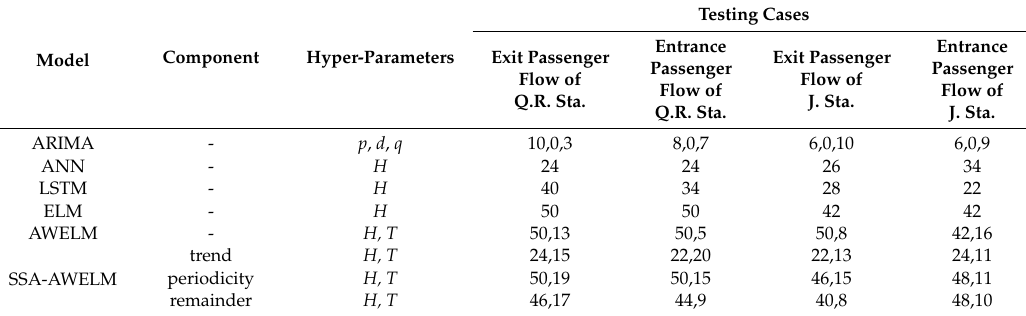
Table A1. The determined hyper-parameters of the experimental